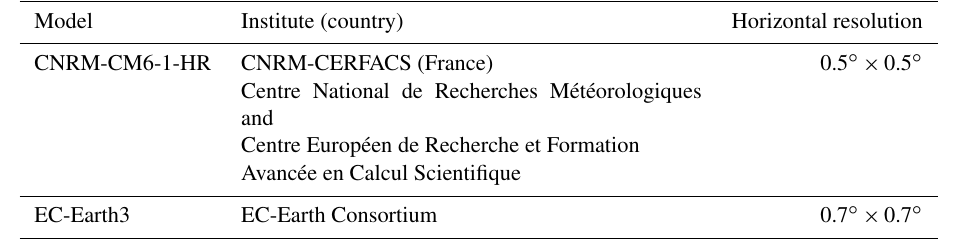
Table 1. Details of the CMIP6 GCMs used in the present study.